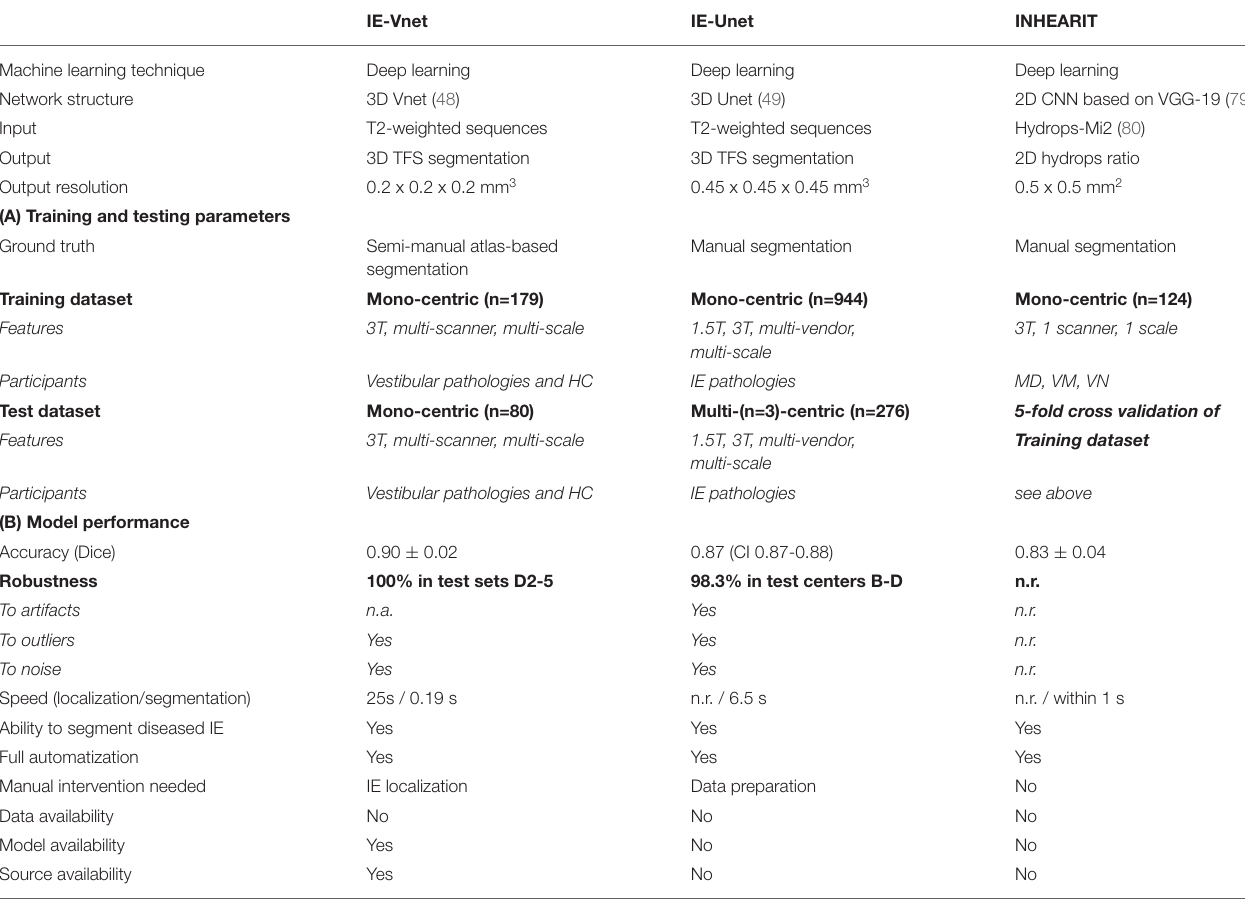
TABLE 3 | Overview of MR IE deep learning segmentation algorithms in